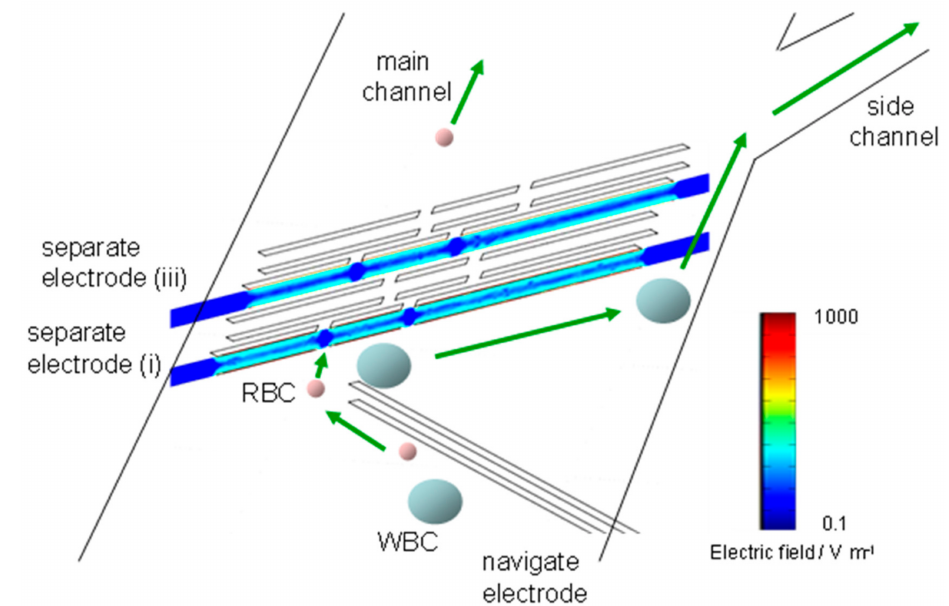
Figure 2. Cross-sectional plots of electric fields along centers of the separation electrodes (i) and